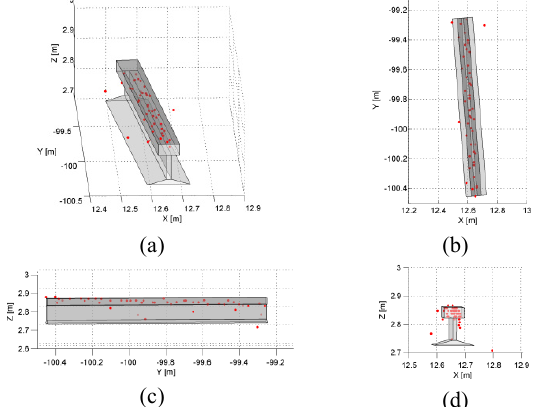
Figure 7. Rail piece fitting result from the perspective view (a), X-Y view (b), Y-Z view (c) and X-Z view (d).